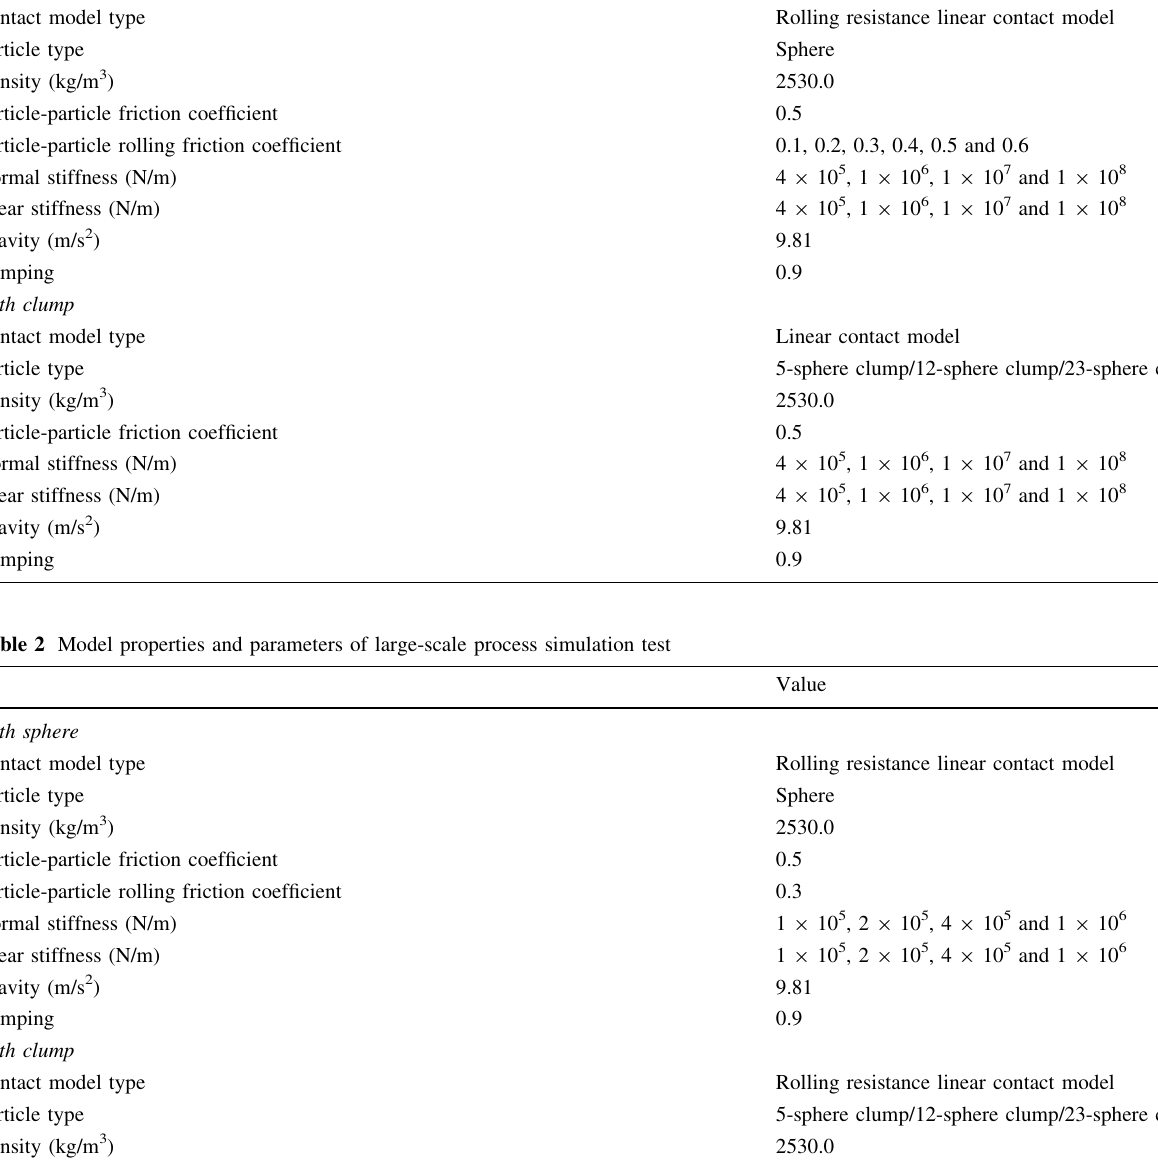
Table 1 Properties of DST model and contact model parameters With